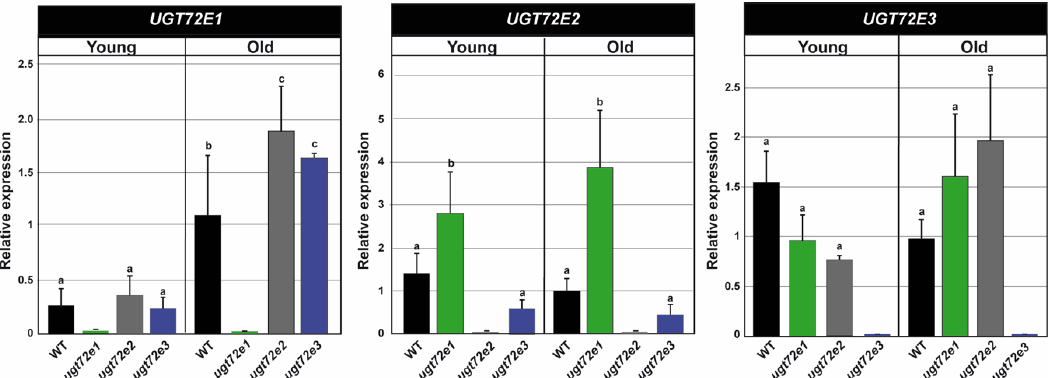
Figure 2. Expression analyses of UGT72E genes in wild type (WT) and ugt72e mutants. RT-qPCR was used to measure the expression of the genes in the old and young parts of the stem. The values are expressed relative to the WT old stem fragments for each analyzed gene. The expression of the genes corresponding to the mutants is null so was not tested statistically. PP2A (AT1G13320) and PEROXIN4 (AT5G25760) were used as internal reference genes. Means with the same lowercase letters are not significantly different according to Duncan test ( p -value < 0.05, n = 3).